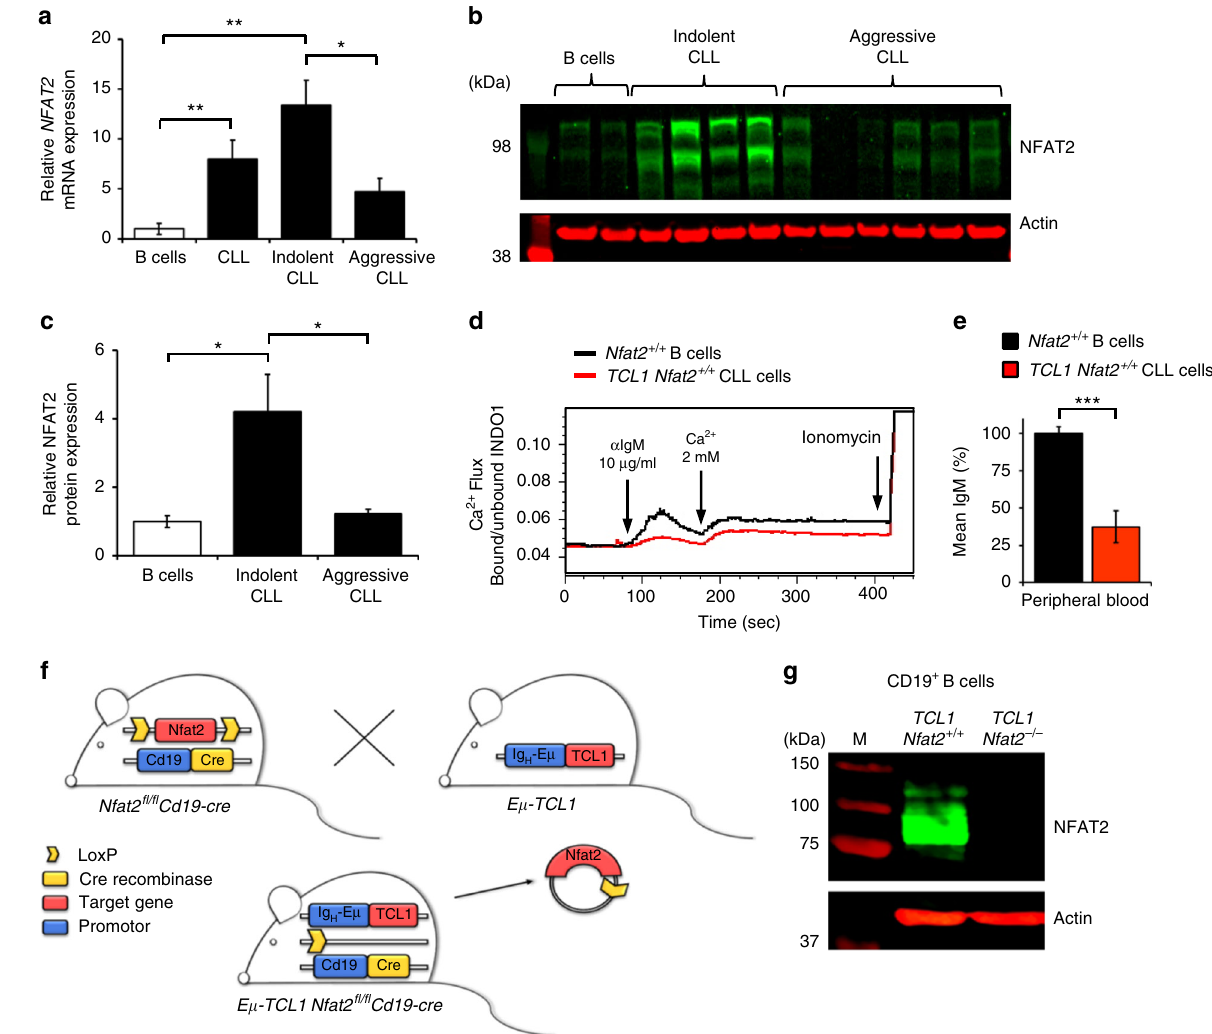
Fig. 1 NFAT2 is overexpressed in CLL cells. a NFAT2 mRNA expression in B cells from healthy volunteers ( n = 3) and human CLL patients ( n = 12), indolent CLL ( n = 6) and aggressive CLL ( n = 6) normalised to Actin assessed by RT-PCR (Welch ’ s t -test, Mean ± S.E.M., * P < 0.05, ** P < 0.01). b NFAT2 protein expression in physiological B cells ( n = 2), indolent CLL ( n = 4) and aggressive CLL ( n = 6) samples assessed by western blotting. One representative blot is shown. c Quantitative analysis of NFAT2 protein expression in physiological B cells ( n = 10), indolent CLL ( n = 7) and aggressive CLL ( n = 8) samples (Welch ’ s t -test, mean ± S.E.M., * P < 0.05). d Ca 2+ fl ux of splenic CD19 + CD5 + cells from 28-week-old Nfat2 +/+ and TCL1 Nfat2 +/+ mice after stimulation with 10 µ g/ml α IgM. Ca 2+ was added after 3 min for extracellular fl ux. 1 µ M ionomycin was added as a positive control. One representative experiment of three independent experiments is shown. e IgM surface expression on B cells from 28-week-old Nfat2 +/+ and TCL1 Nfat2 +/+ mice determined by fl ow cytometry ( n = 5 per group) (Student ’ s t -test, Mean ± S.E.M., * P < 0.05). f Mouse breeding scheme to generate E µ -TCL1 Nfat2 fl / fl Cd19-Cre mice. g